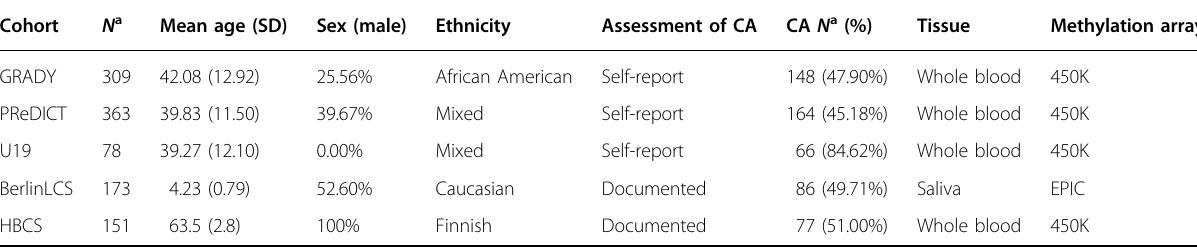
Table 1 Demographic overview of